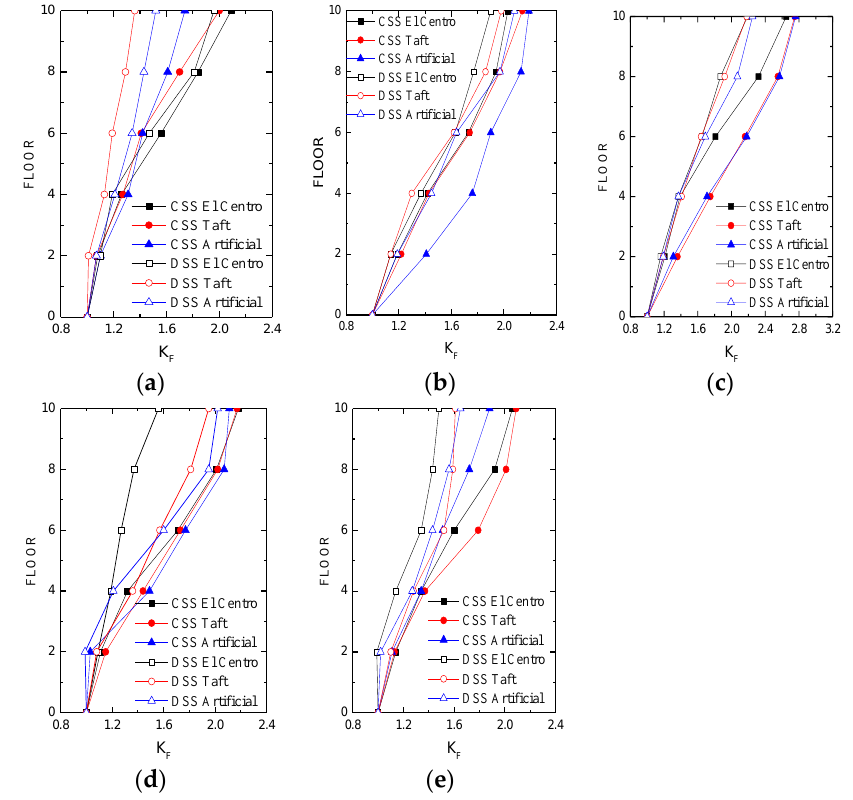
DSS — damping suspended structure; CSS — conventional suspended structure Figure 8. Amplification factor of acceleration. ( a ) 7 frequent earthquake; ( b ) 8 frequent earthquake; ( c ) 9 frequent earthquake; ( d ) 7 rare earthquake; ( e ) 8 rare earthquake.